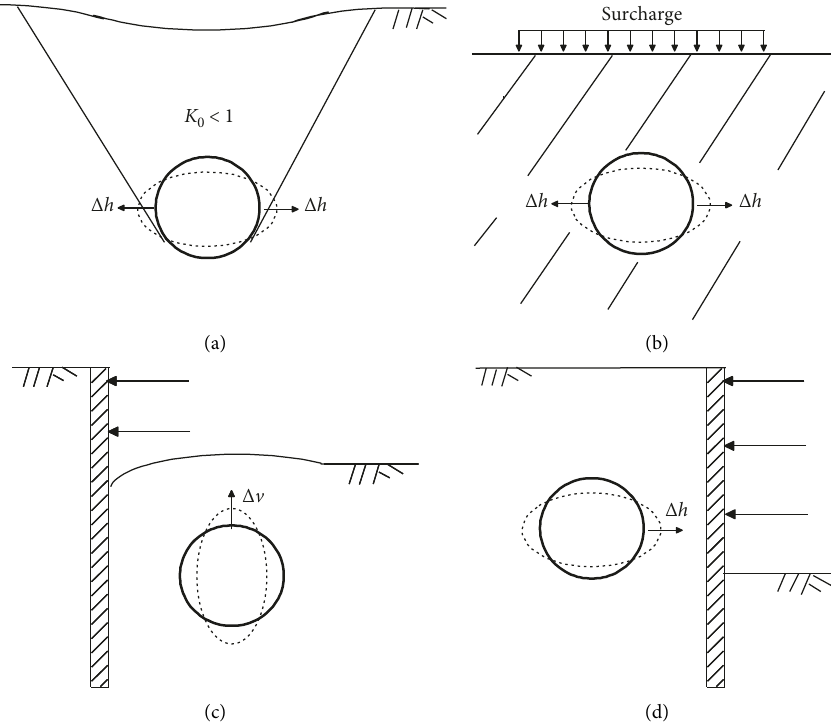
Figure 16: Different types of tunnelling-related problems and their associated matching criteria (Lee and Ge [20]). (a) Prediction of ground surface settlement (matching Δ h ). (b) The influence of subsequent surcharge loading on the ground surface (matching Δ h ). (c) The influence of excavation directly above an existing tunnel (matching Δ v ). (d) The influence of excavation adjacent to an existing tunnel (matching Δ h ).